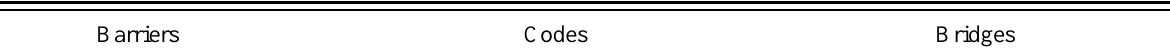
Table 5 . Programmatic bridges and barriers to integrated interdisciplinary